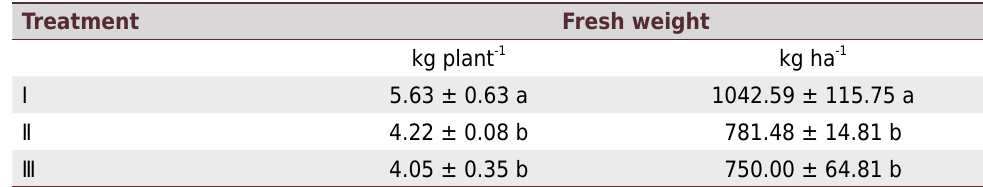
Table 1. Fresh weight of alfalfa under different treatments Treatment